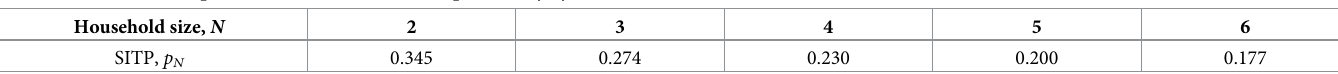
Table 2. Estimated susceptible-infectious transmission probability by household size from House et al.